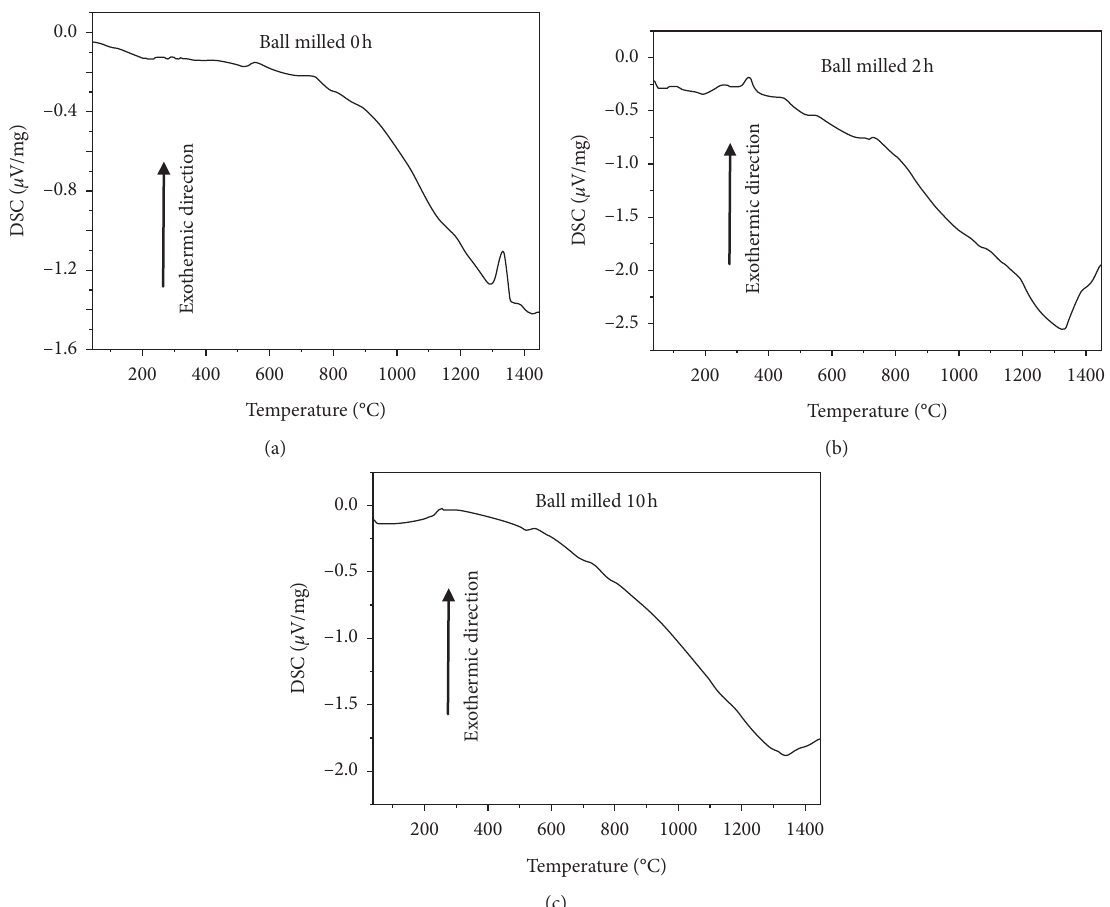
Figure 10: DSC curve of the milled powders with different milling time; (a) for 0h; (b) for 2 h; (c) for